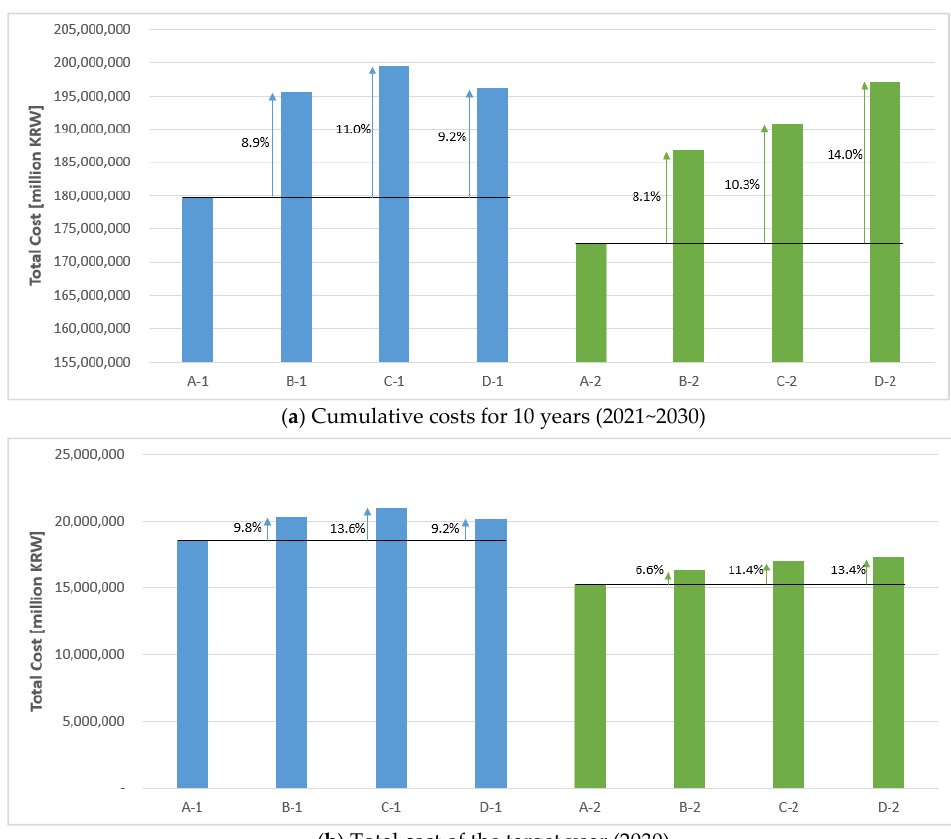
Figure 7. Total generation cost of all scenarios ( a ) 10 years; ( b ) target year.